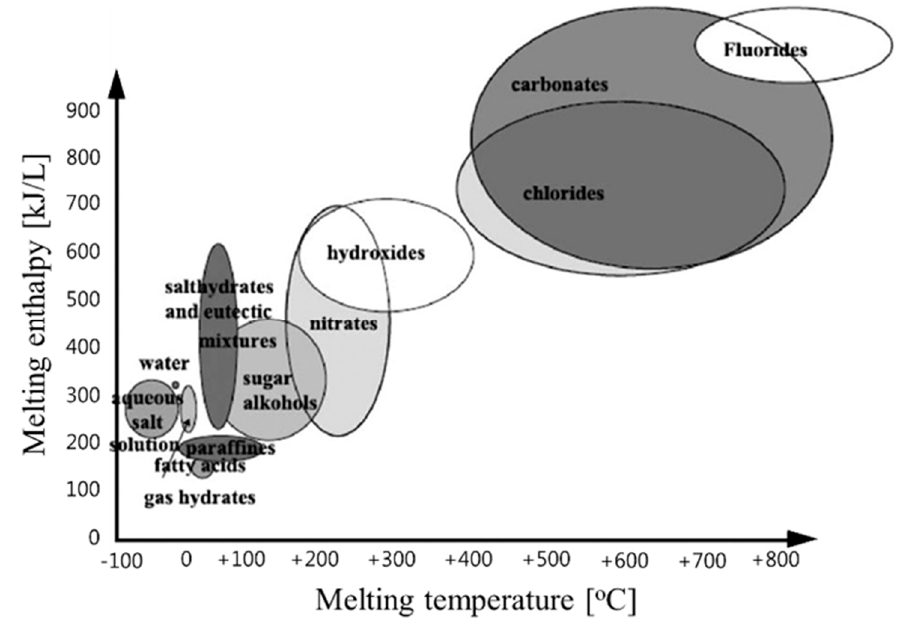
Figure 2. Classes of materials that can be used as thermal storage materials [68].